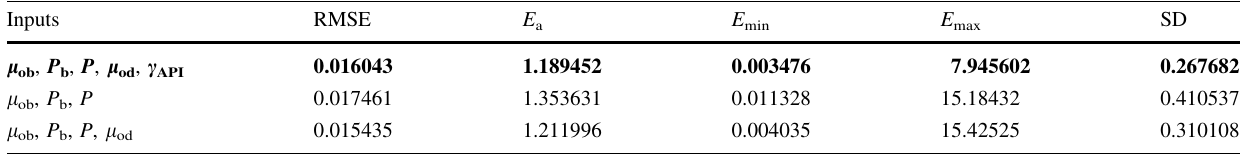
Table 9 Performance of the ensemble SVR for the functional forms for l oa Inputs